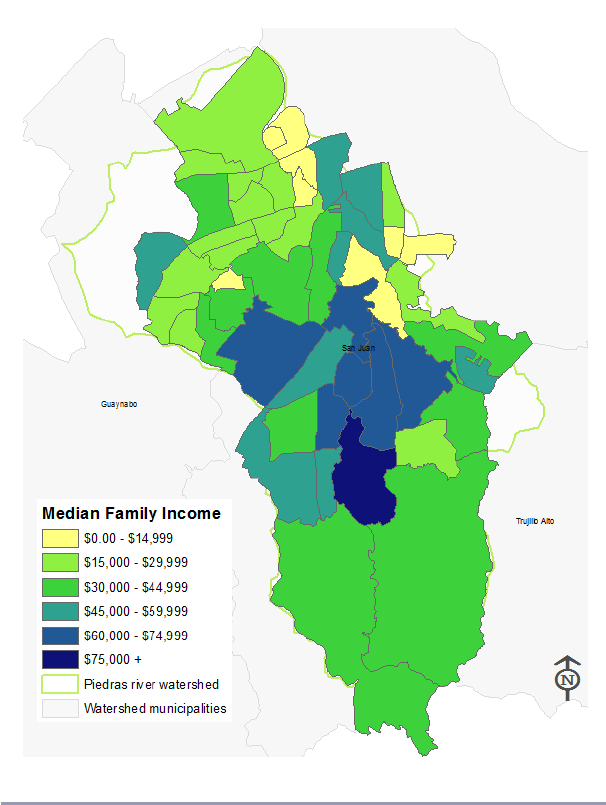
Fig. 1. Median family income by census tract.